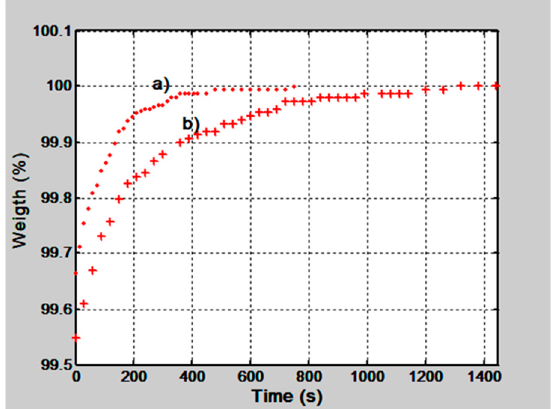
Figure 4. Behavior of the normalized weight of a gelatin thin film, 15 µm thickness, when it was in its unhardened state a) and hardened one b).